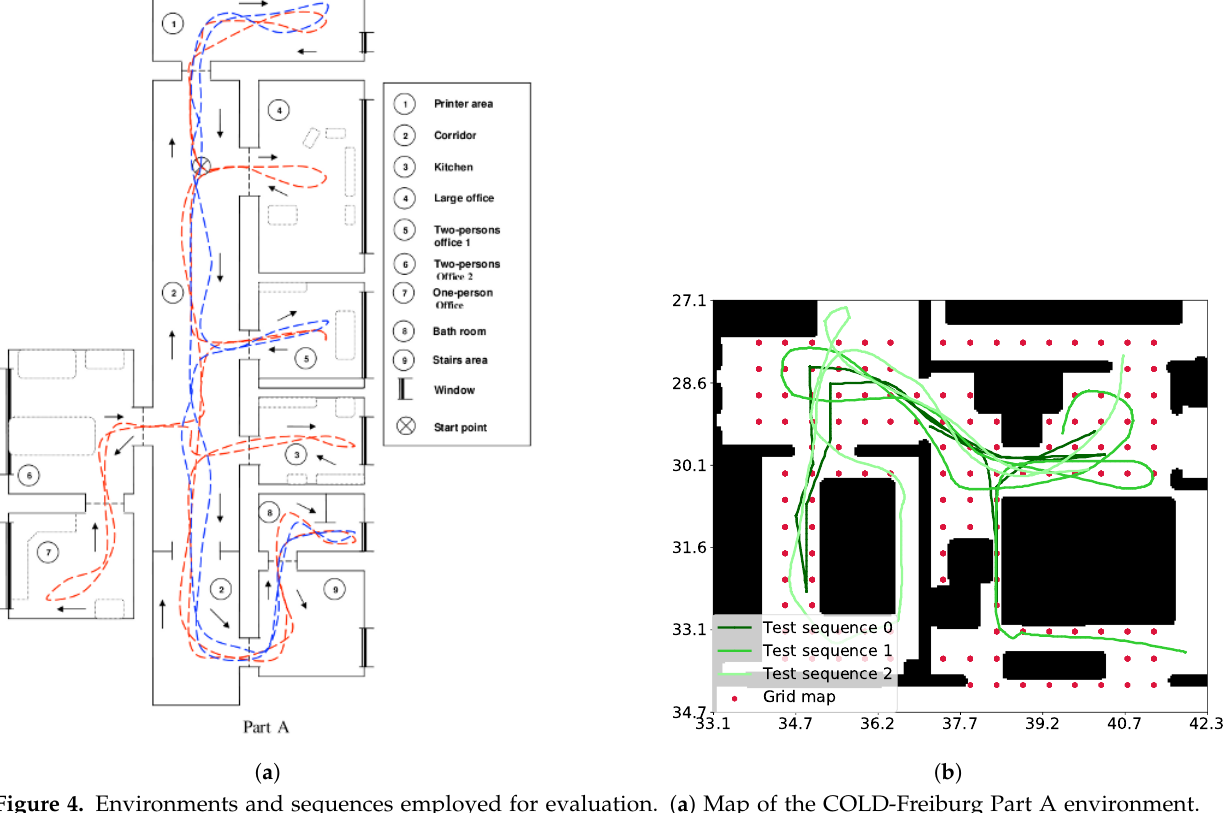
Figure 4. Environments and sequences employed for evaluation. ( a ) Map of the COLD-Freiburg Part A environment. Samples of the standard and extended routes are depicted in blue and red, respectively (image from [45]). ( b ) Map of the house rendered by the SUNCG environment (the house employed was 034e4c22e506f89d668771831080b291 ). The dense grid poses are shown in red and the test sequences in different shades of green. Black regions depict objects, where the robot is not able to